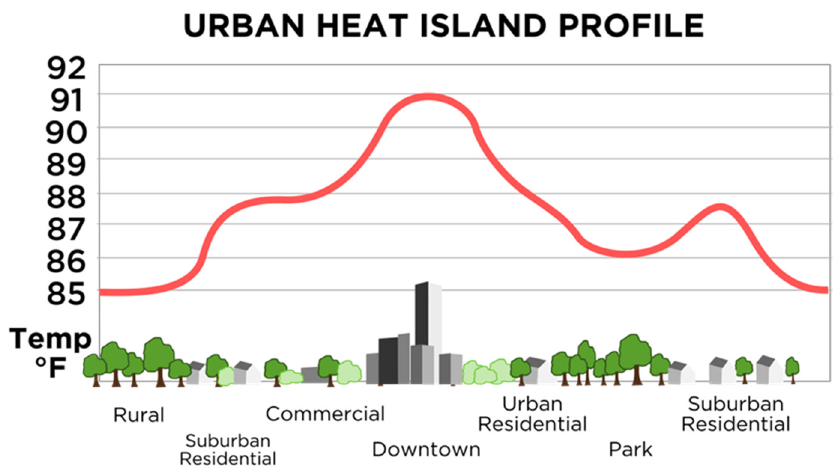
Figure 8. Urban Heat Island representation.